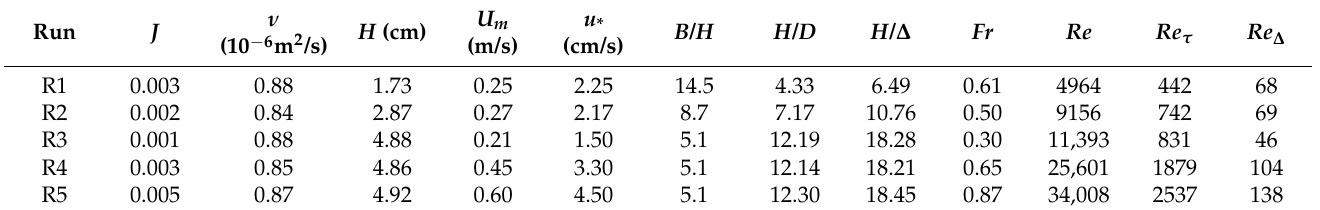
Table 1. Flow conditions (a) .